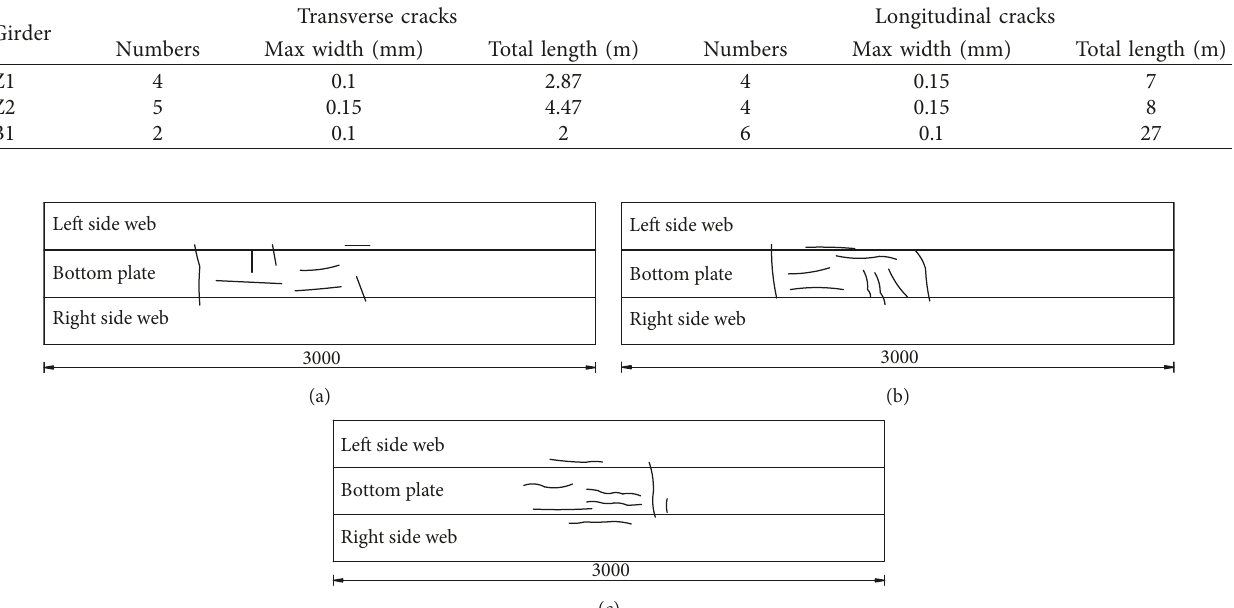
Figure 3: Visible cracks of the test girders (unit: cm). (a) Girder Z1. (b) Girder Z2. (c) Girder B1.